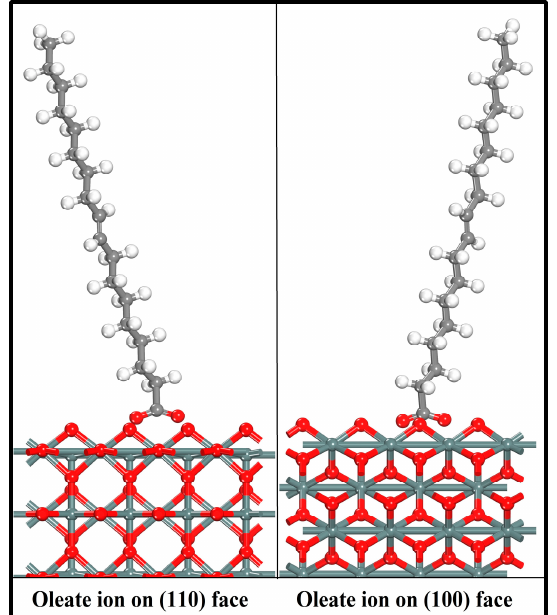
Figure 7. Optimized adsorption configurations of oleate over cassiterite (110) and (100) surfaces (colour codes: Gray—C, White—H, Red—O, Dark Gray—Sn).